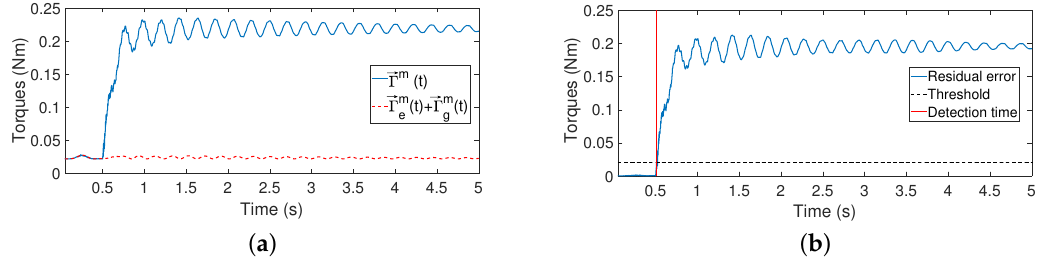
Figure 11. Estimation of the instant of contact: ( a ) Measured and estimated coupling torques; ( b ) residual